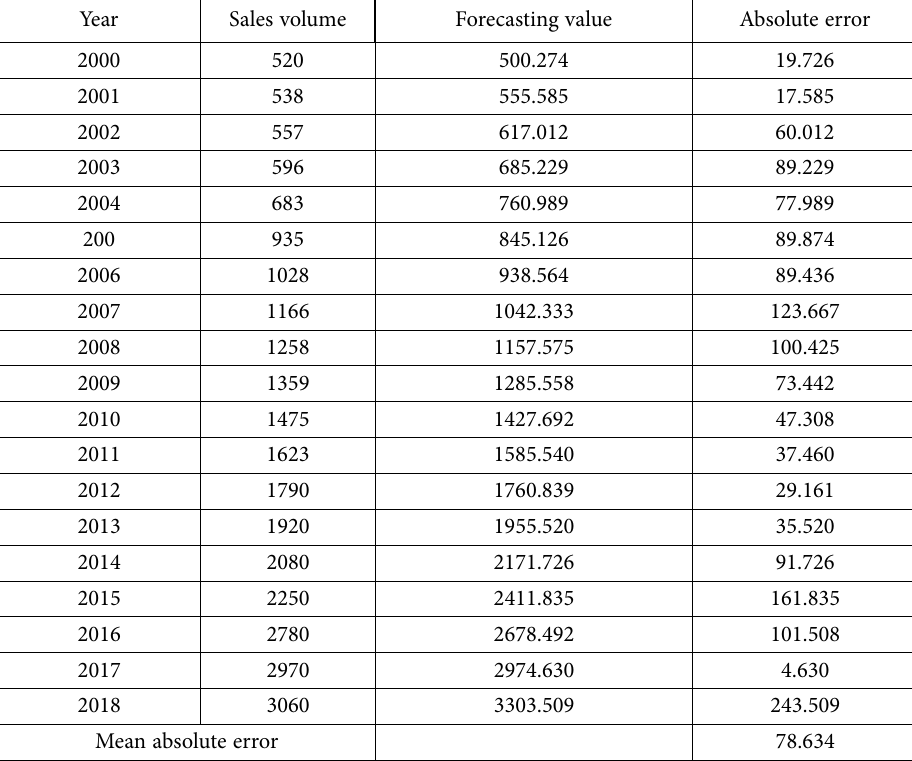
Table 3. Forecasting value of the sales volume based on the RA